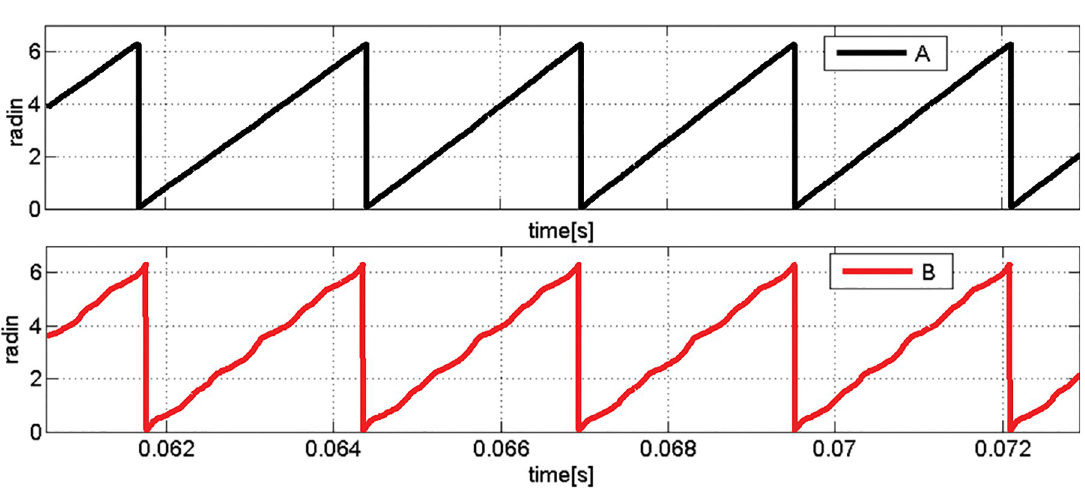
Fig 10. Comparison of simulation results of θ